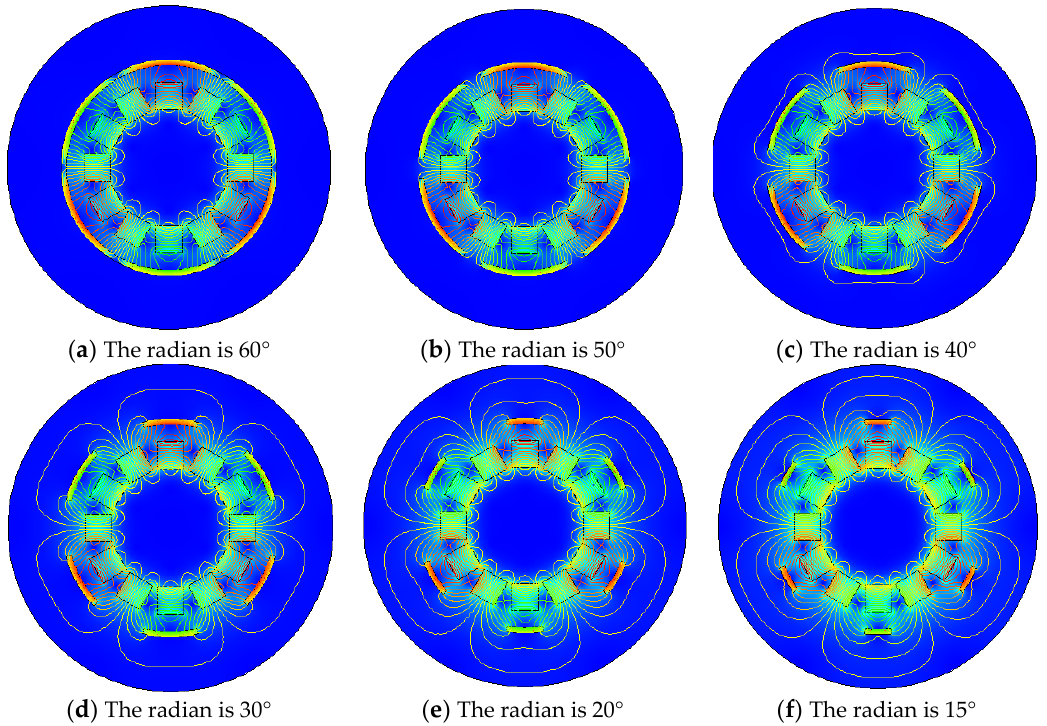
Figure 7. Magnetic field distribution of Halbach array under different iron sheet radians.